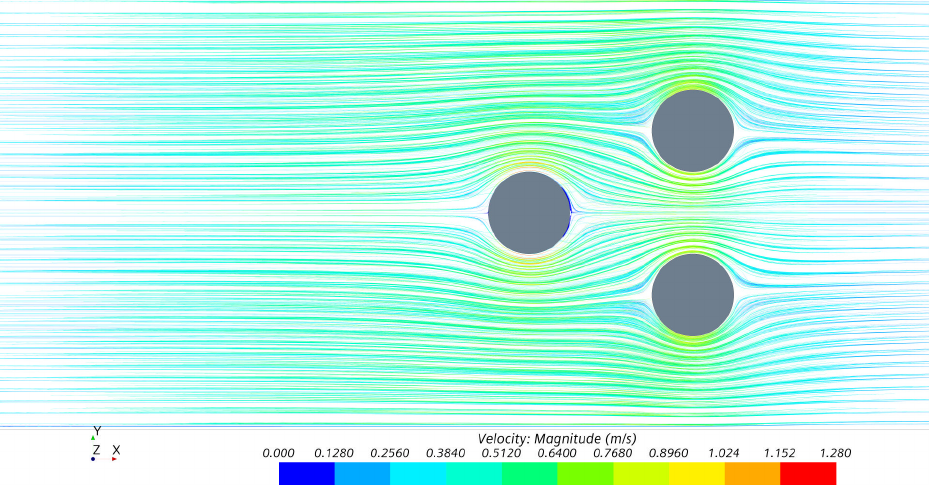
Figure 20. URANS predicted flow velocities at z = − 0.074 m of the flow field surrounding the tripod configuration, consisting of the medium-diameter cylinders, taken after a simulation time of 12.0002 s. These URANS simulations nicely captured the wake generated behind the upstream cylinder as it influenced the flow past the downstream cylinders. For comparison, Figure 21 presents the simulated streamlines without the presence of the cylinders, taken at the